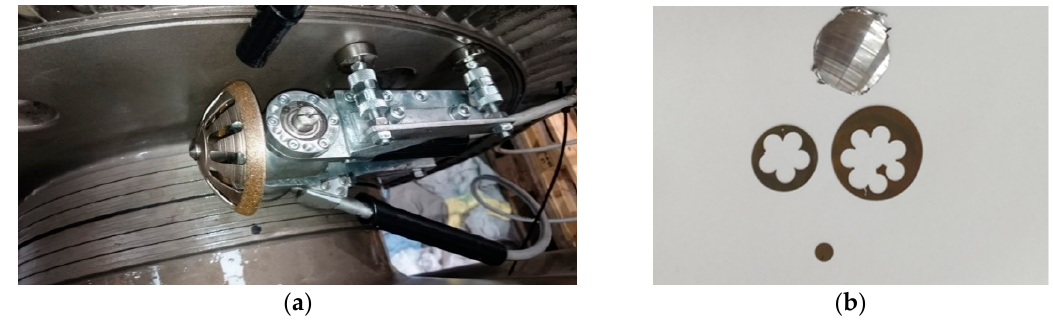
Figure 4. Specimen sampling from a 200 MW turbine rotor disc ( a ) device for specimen sampling ; ( b ) rotor material specimen and the microspecimens made from it.